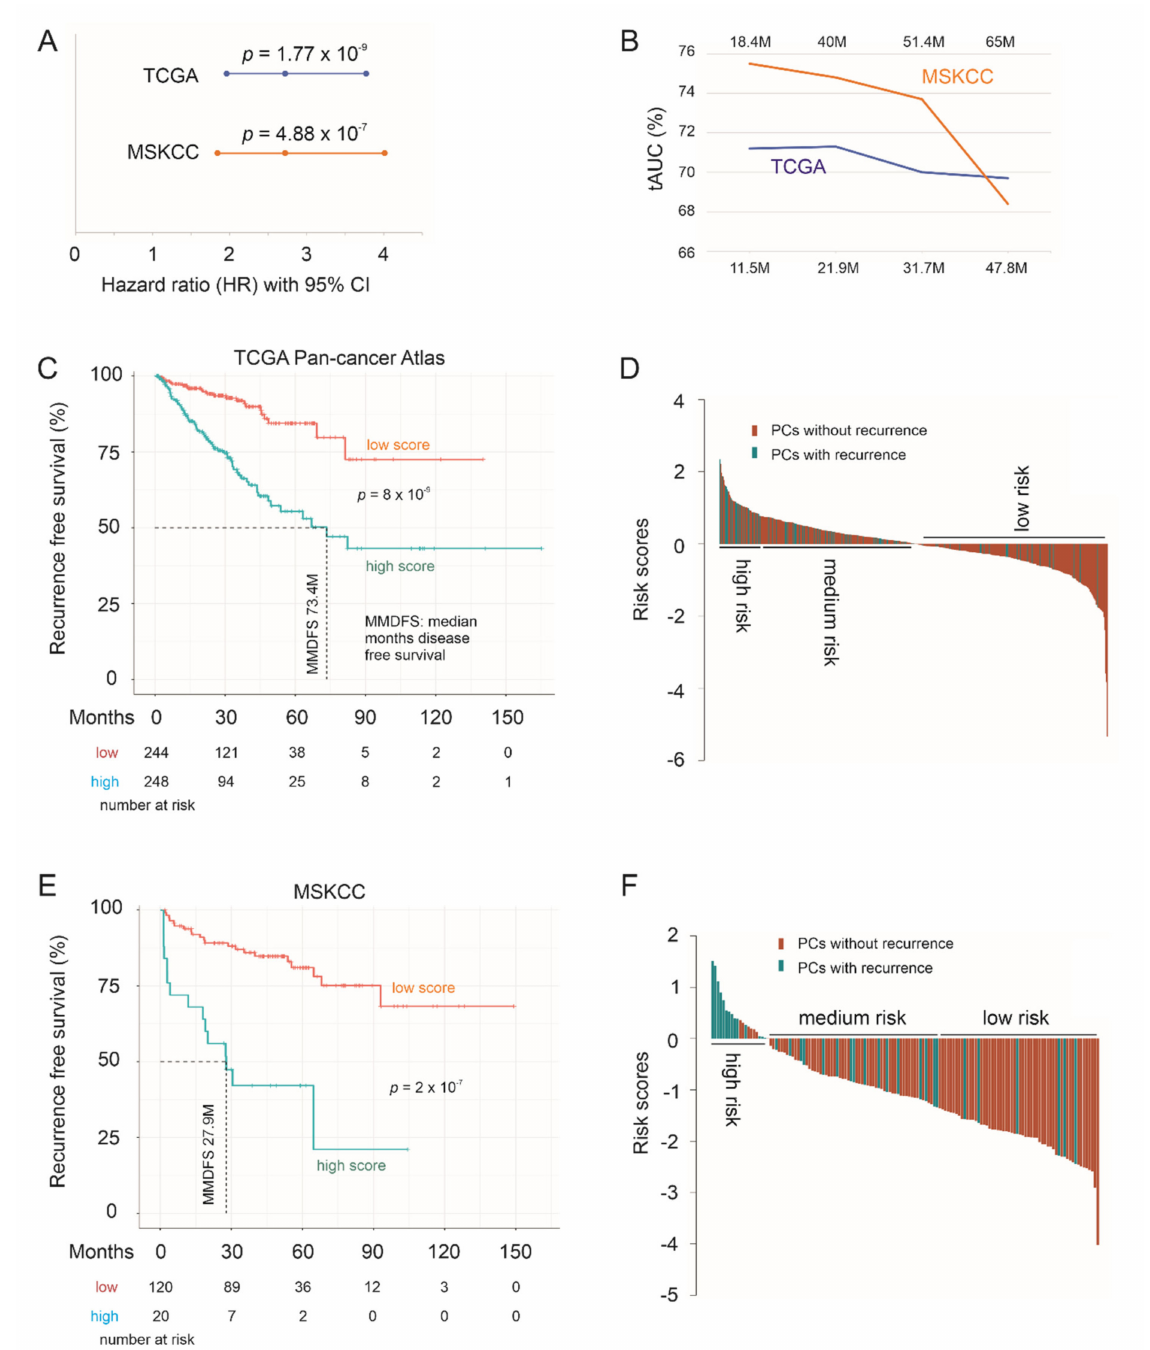
Figure 10. The LE gene panel robustly predicts PC recurrence. ( A ) hazard ratio (HR), 95% CI, and p values for LE panel scores in predicting PC relapse. ( B ) Time-dependent receiver operating characteristic (ROC) curve. The time scales above and below are for the MSKCC and TCGA PanCancer cohort, respectively. ( C – F ) Kaplan–Meier survival curves and the risk score waterfall plot are for the TCGA ( C , D ) and MSKCC ( E,F ) cohort. For waterfall plots, the cutoff points were used as the baselines. Statistical analyses were performed using log rank